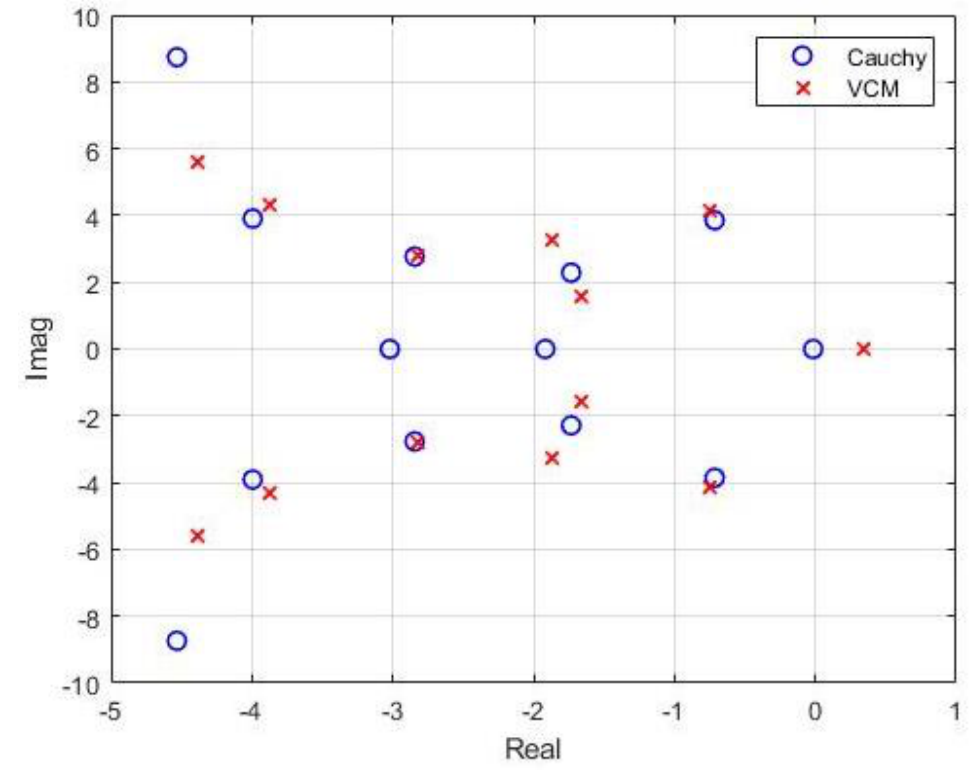
Figure 3. CNRs calculated with the Cauchy and VCM methods for a simulated metal